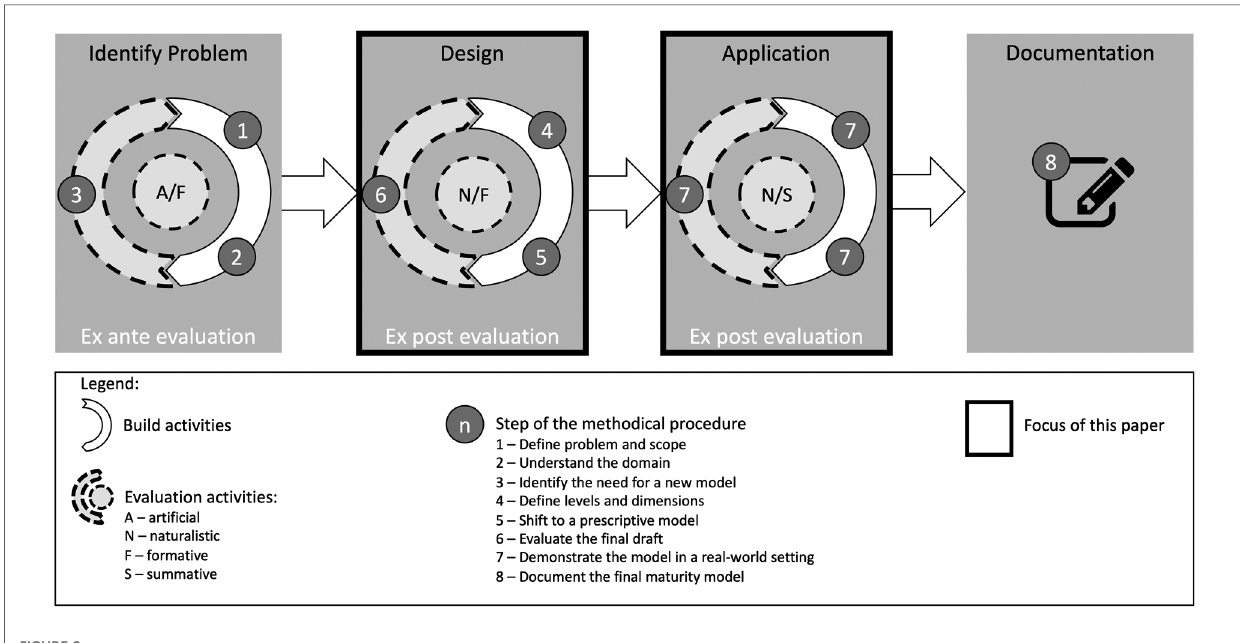
FIGURE 2 Methodical process to design the TCRM (re fi ned research process based on